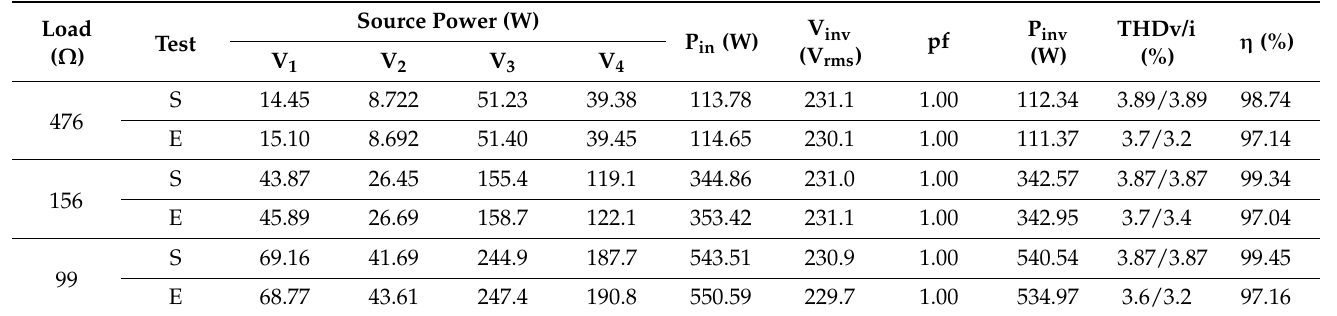
Table 7. Simulation (S) and experimental (E) tests of the full system with 17 L inverter under R load.